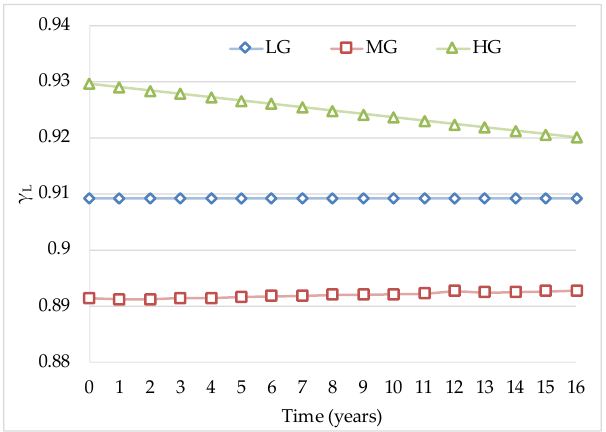
Figure 6. PSF ( γ L ) for the load as a function of time.